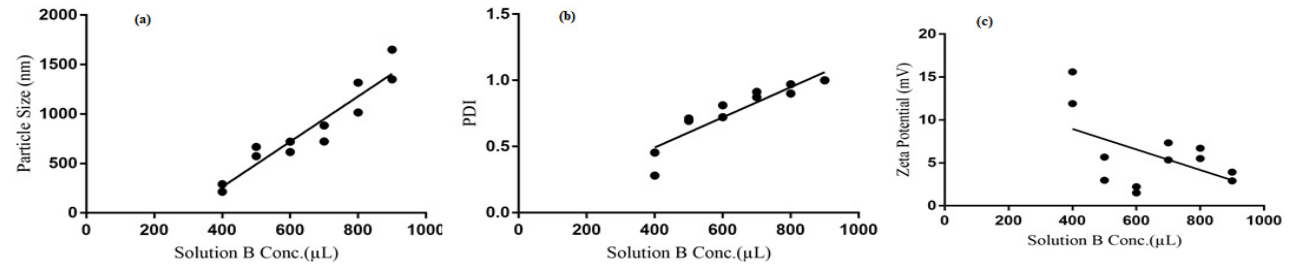
Table 4. Linear regression analysis for effect of independent variables on PDI Independent Variables